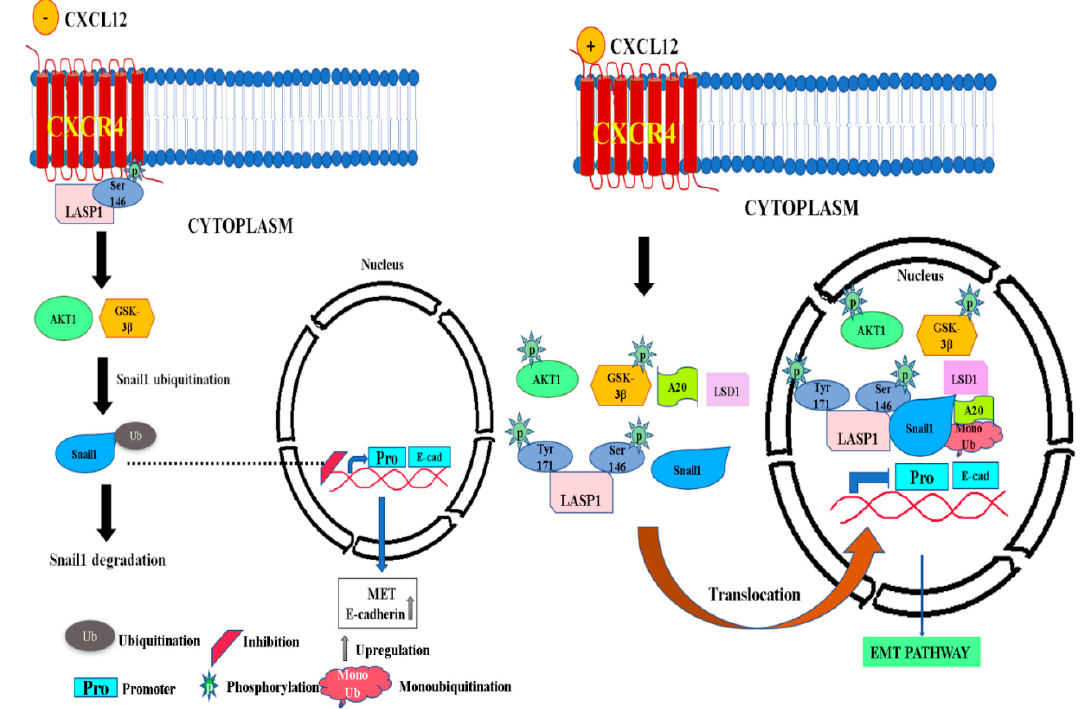
Figure 6. A working model illustrating the role of CXCR4-LASP1 axis in promoting the stabilization of nuclear Snail1. Left panel: A proposed model illustrating the cellular situation when CXCL12 is absent—In the absence of any activation of CXCR4 by CXCL12, the constitutively phosphorylated LASP1 at S146 (pS146-LASP1) is bound to inactive, unliganded CXCR4 at the plasma membrane. Phosphorylation of Snail1 by GSK-3 β on specific residues results in cytosolic localization of Snail1. Cytoplasmic Snail1 undergoes additional phosphorylation by GSK-3 β , which marks Snail1 for ubiquitination and subsequent proteasomal degradation. Gene expression of E-cadherin is not repressed by Snail1, though repression by other transcription factors such as ZEB1 is not ruled out. This happens in epithelial cancer cells. Right panel: Activation of CXCR4 by CXCL12 leads to the phosphorylation of LASP1 at Y171 and translocation of LASP1. Additionally, active CXCR4 induces phosphorylation/activation of Akt (pS473-AKT) through the PI3K pathway, which traverses to the nucleus and initiates the phosphorylation/inhibition of nuclear GSK-3 β (pS9-GSK-3 β ). Concurrently, the CXCR4 signaling increases the nuclear levels of A20 and LSD1. Each of these proteins induces the stabilization of Snail1 in a variety of ways. A20 mediates monoubiquitination of Snail1 thus reducing its affinity for GSK-3 β . Nuclear shuttled LASP1 and elevated LSD1 level may physically shield Snail1 and prevent access of GSK-3 β to Snail1. The association of pLASP1 with Snail1, pAKT, A20 and LSD1 in the form of several complexes of differing compositions will protect and stabilize Snail1. The stabilized Snail1 represses the promoter region of E-cadherin. This happens in mesenchymal cancer cells. Snail1: Snail family transcriptional repressor; LASP1: LIM and SH3 protein 1; Akt: Protein kinase B; GSK-3 β : Glycogen synthase kinase-3 β ; LSD1: lysine-specific histone demethylase 1; A20: TNF- α induced protein 3; E-cad: E-cadherin; Ub: Ubiquitination.